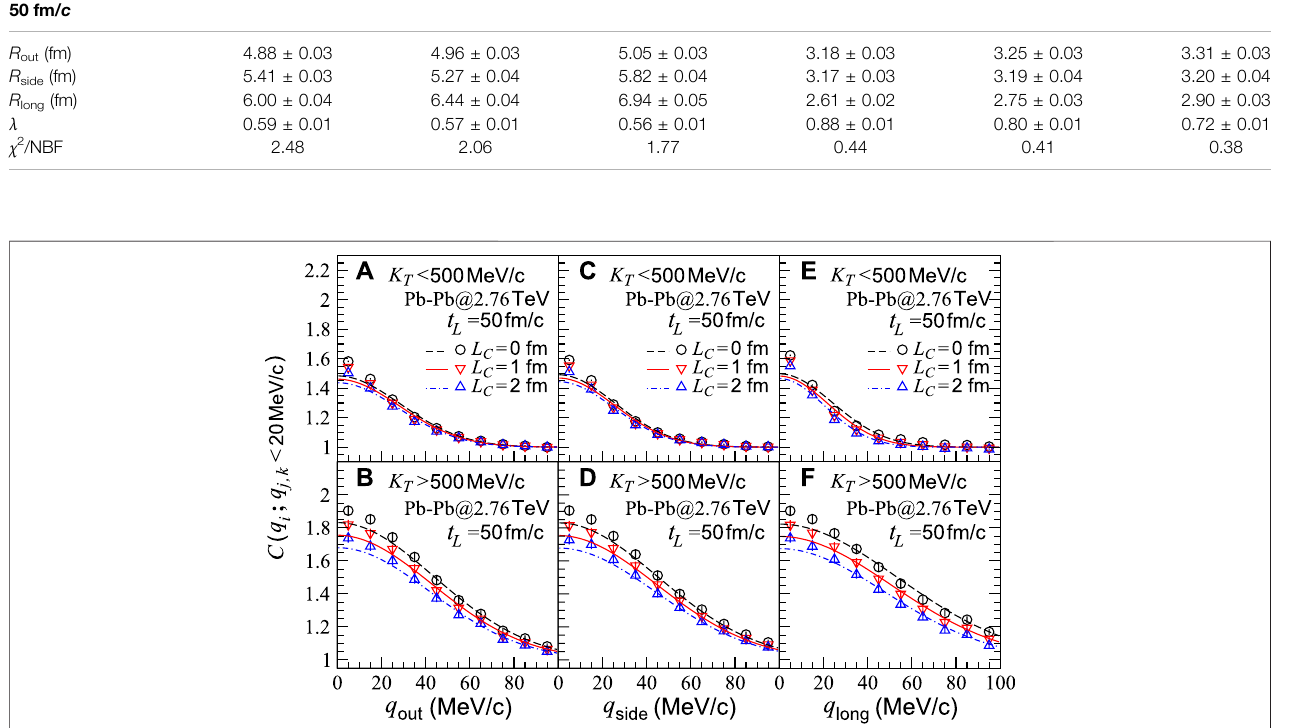
FIGURE 6 | Two-pion correlation functions with respect to relative momenta q i , j , k ( i , j , and k = out, side, and long) for sources in central Pb-Pb collisions at (cid:1)(cid:1)(cid:1)(cid:1) √ (cid:3) 2 . 76 TeVandwith t s NN L =50 fm/ c .Upperpanelsplotthetransversemomentumrange K T and down-triangle symbols denote coherent emission lengths L C = 0, 1, and 2 fm, respectively. Lines are fi tted